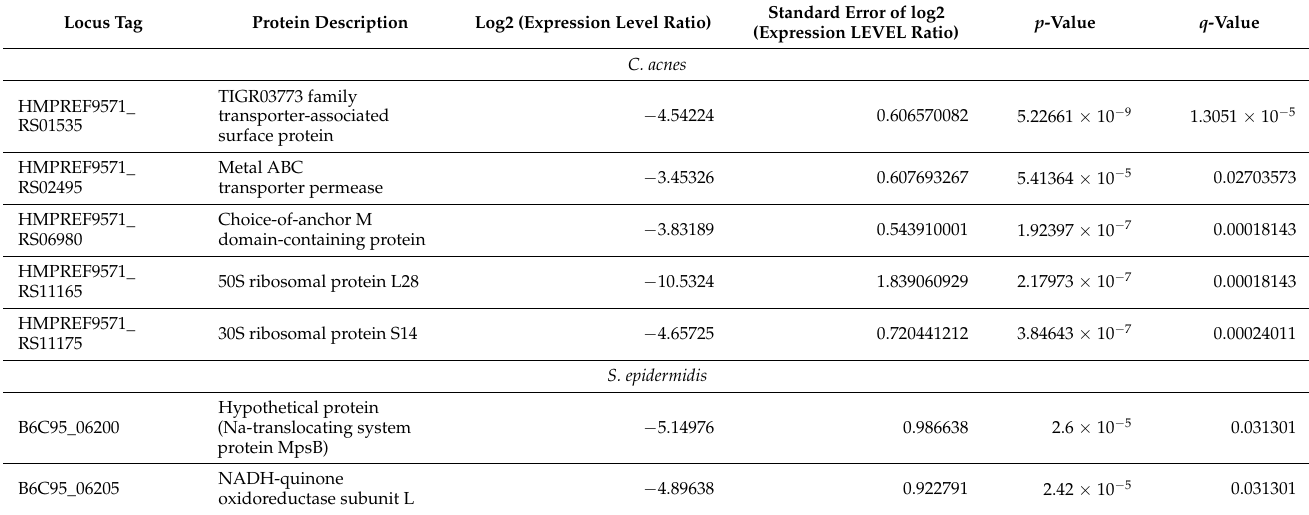
Table 5. Differential expression in dual-species biofilms in the presence of CNP, revealed via